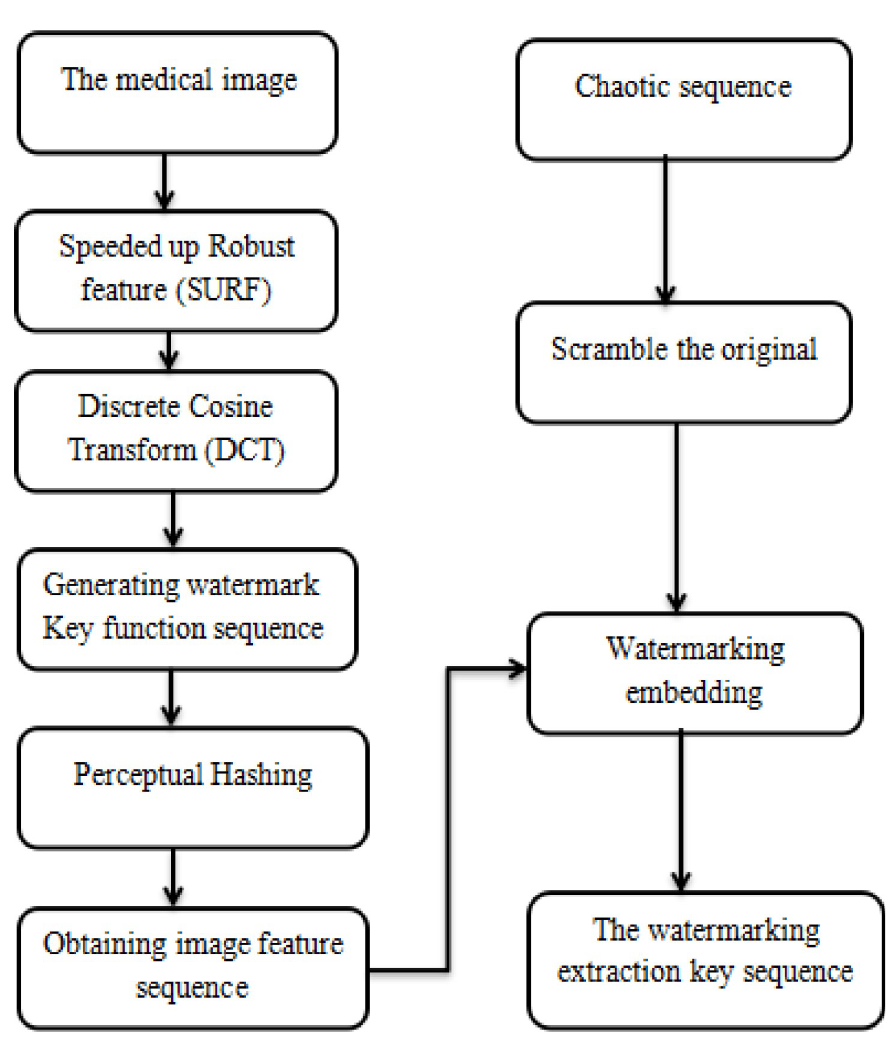
Fig 7. The flow of watermark